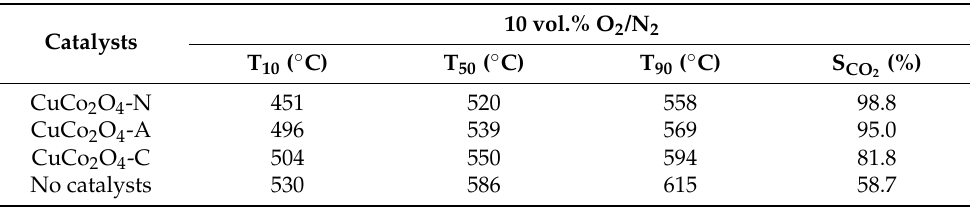
Figure 7. Soot conversion over the CuCo 2 O 4 - x ( x = N, A and C) catalysts under loose contact mode under the carrier gas of 10 vol.% O 2 with balanced N 2 . Table 3. Catalytic activity of the CuCo 2 O 4 - x ( x = N, A and C) catalysts for soot combustion under loose contact mode in 10 vol.% O 2 with balanced N 2